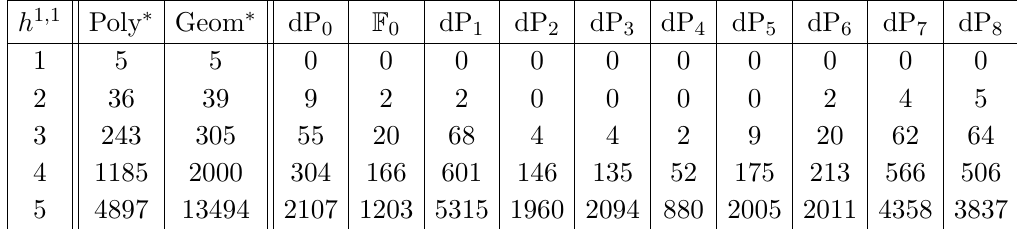
Table 8 . Number of CY geometries with a particular type of del Pezzo divisor.